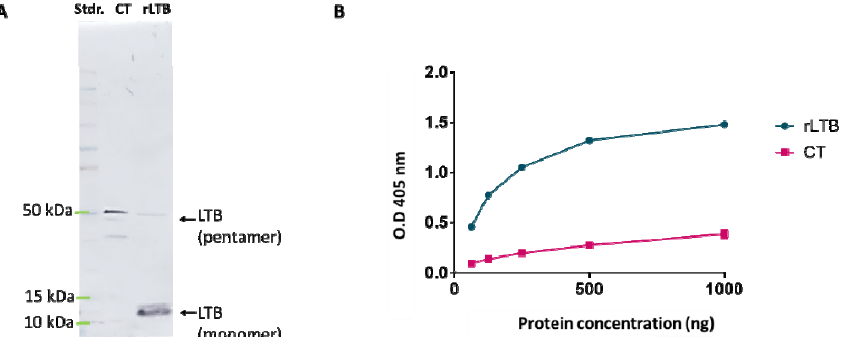
Figure 2. Biological reactivity of rLTB analyzed by immunoblotting ( A ) and a GM1 ganglioside- binding assay ( B ). Immunoblotting was performed using specific sera against LT, using the cholera toxin (CT) as a control; the identity of reacting bands is indicated. Panel B shows the degree of binding affinity of rLTB for the specific receptor GM1. The ELISA experiment was performed by incubation of coated GM1 with purified rLTB or with CT-B as a positive control.